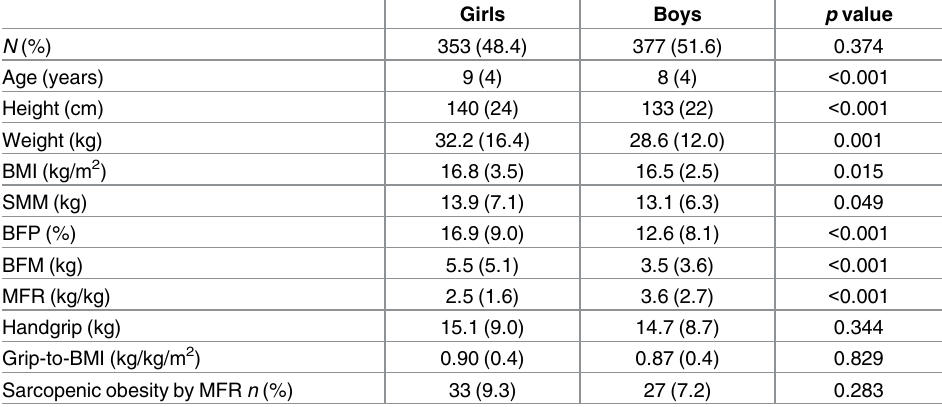
Table 1. Descriptive statistics of boys and